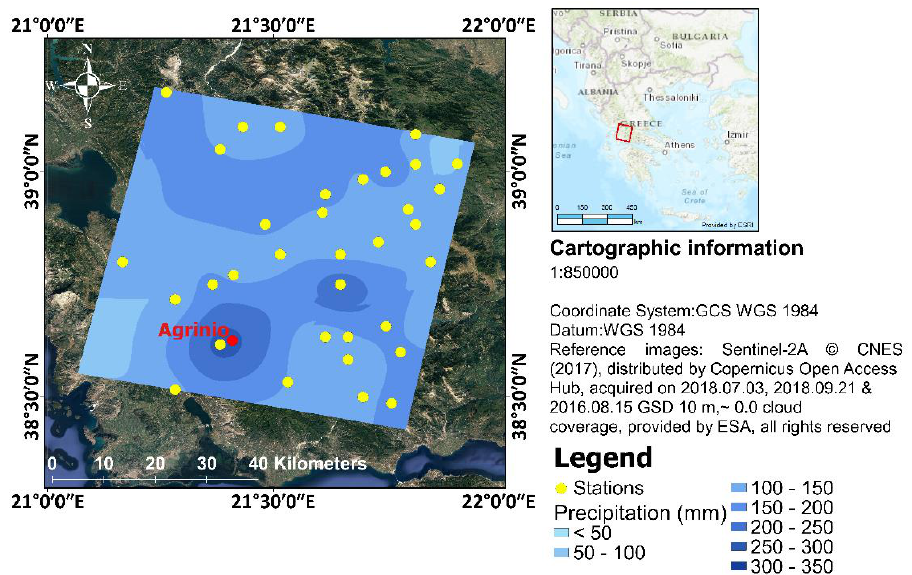
Figure 4. Precipitation map derived from the observations of the in situ meteorological stations (Ministry of Environment and Energy, http://www.hydroscope.gr/, accessed on 17 March 2021) of 50-year return period for the study area.